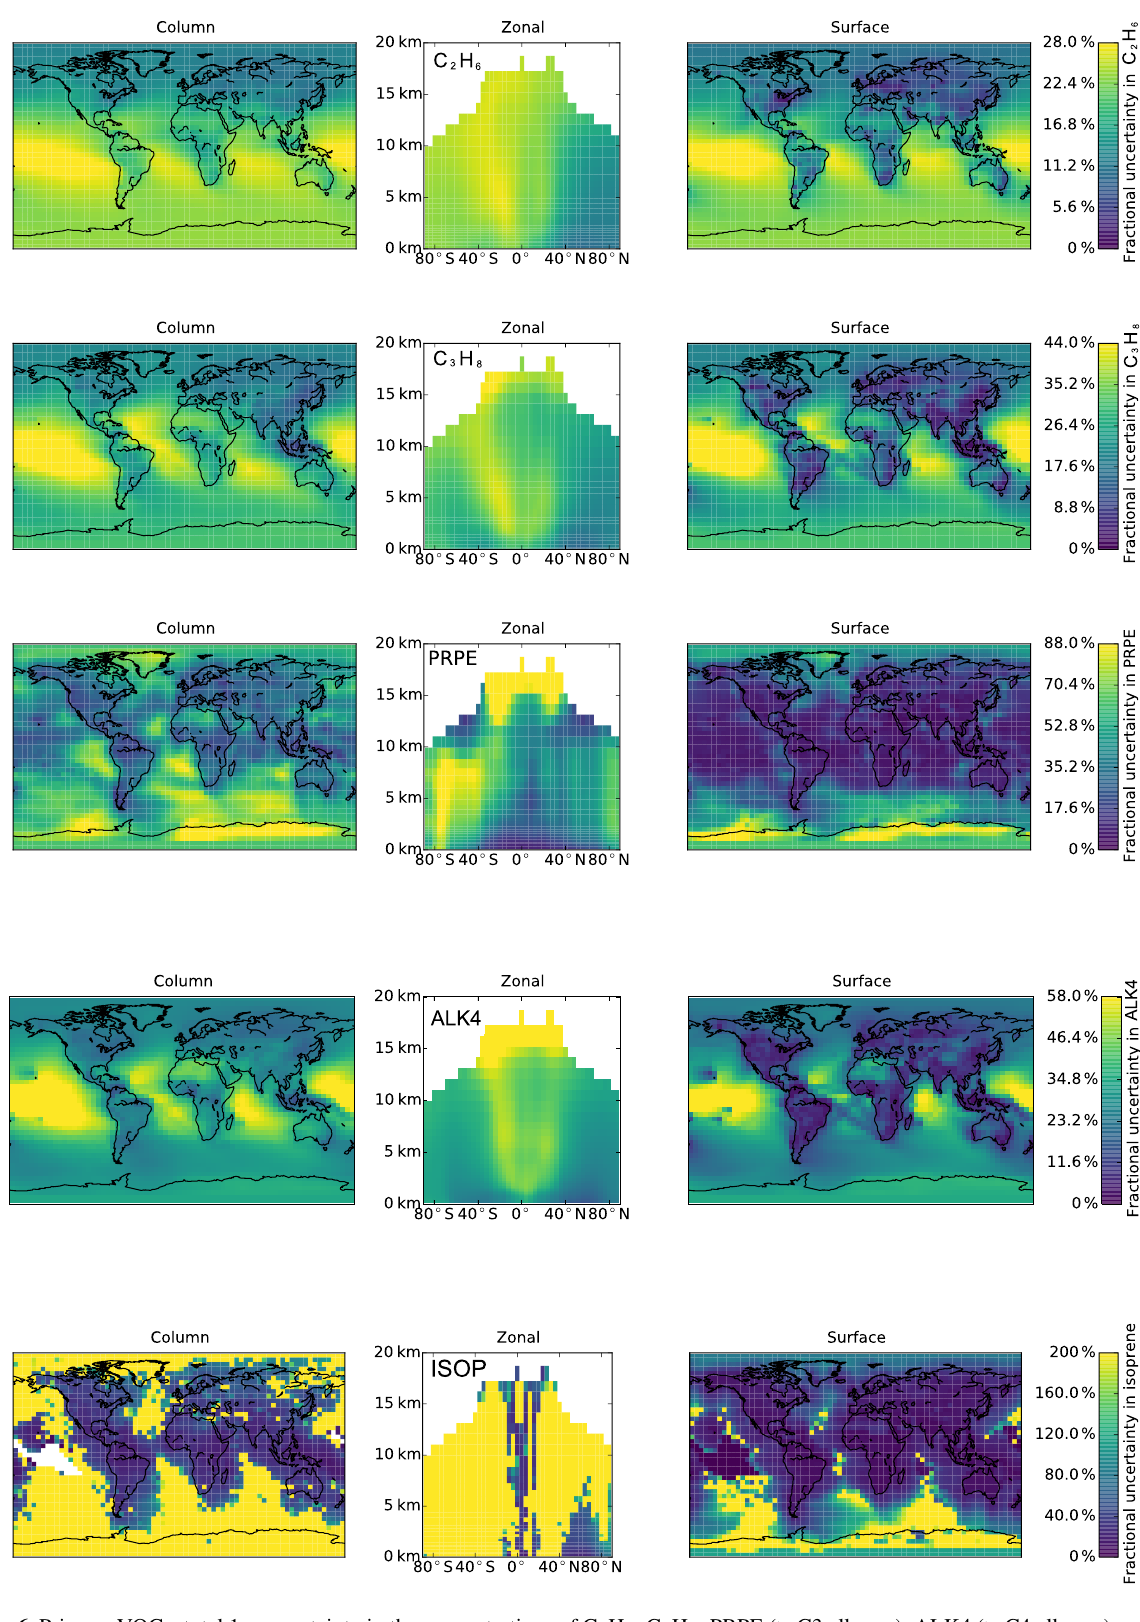
Figure 6. Primary VOCs: total 1 σ uncertainty in the concentrations of C 2 H 6 , C 3 H 8 , PRPE ( ≥ C3 alkenes), ALK4 ( ≥ C4 alkanes) and ISOP (isoprene) from the addition in quadrature of the individual reaction uncertainties. “Column” covers the tropospheric column.